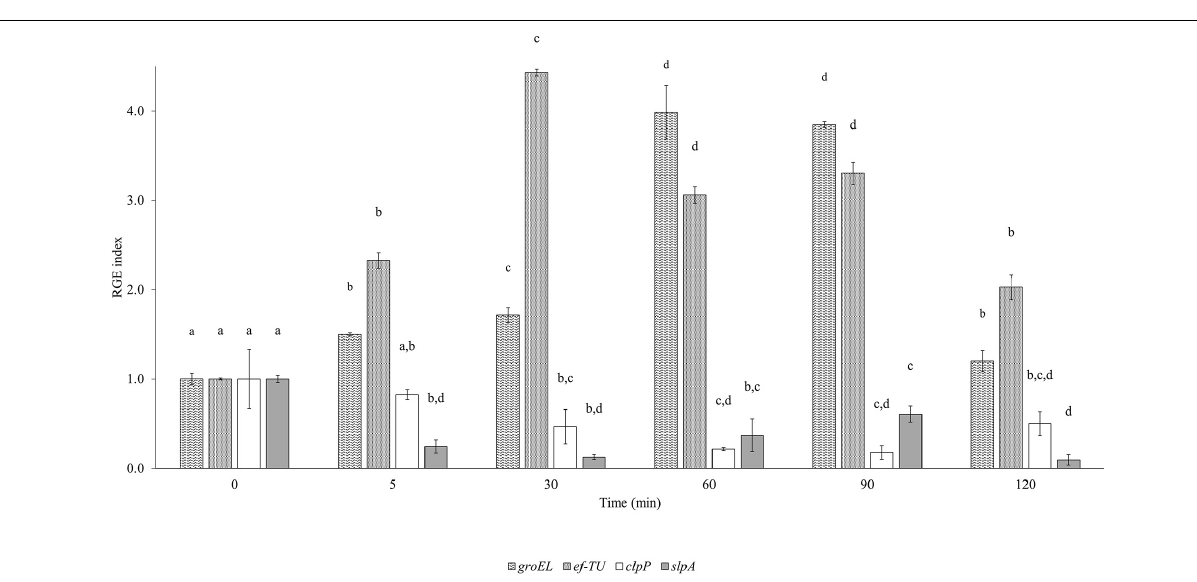
FIGURE 5 | Evolution of the Relative Gene Expression (RGE) index of Lactobacillus acidophilus 08 groEL (60 kDa chaperonin), ef-TU (elongation factor-TU), clpP (ATP-dependent Clp protease proteolytic subunit), and slpA (S-layer porotein A) genes after high pressure homogenization at 50 MPa using 23S RNA as the reference gene. Results are the mean of three independent replicates ( n = 3) collected in a time frame of 0–120 min. Error bars indicate the SD. Different letters are referred to the significant differences ( p < 0.05) of the RGE of each gene during the frame time